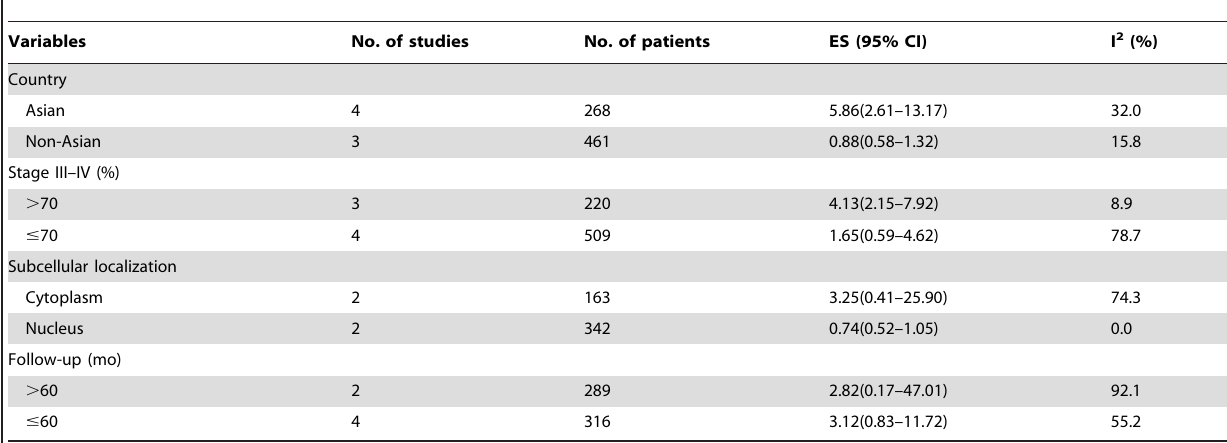
Table 2. Associations between CXCR4 expression and OS of ovarian cancer grouped by selected factors.